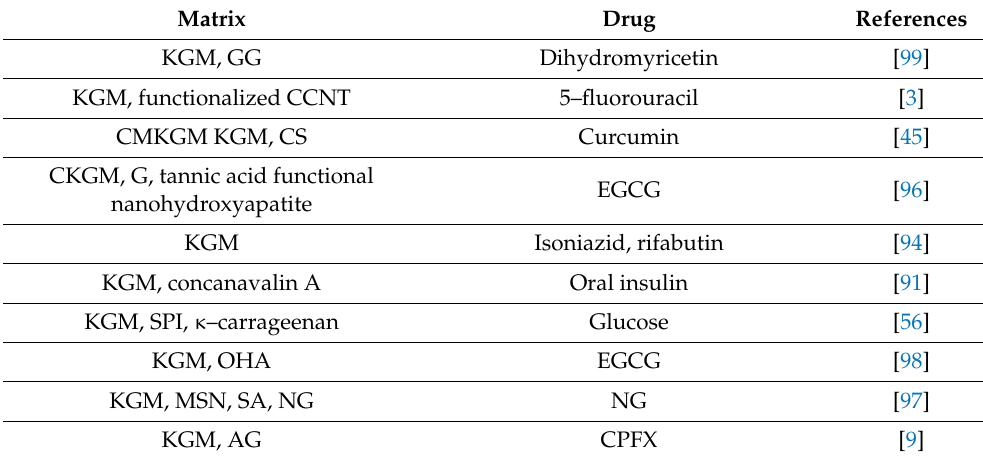
Table 3. KGM as drug